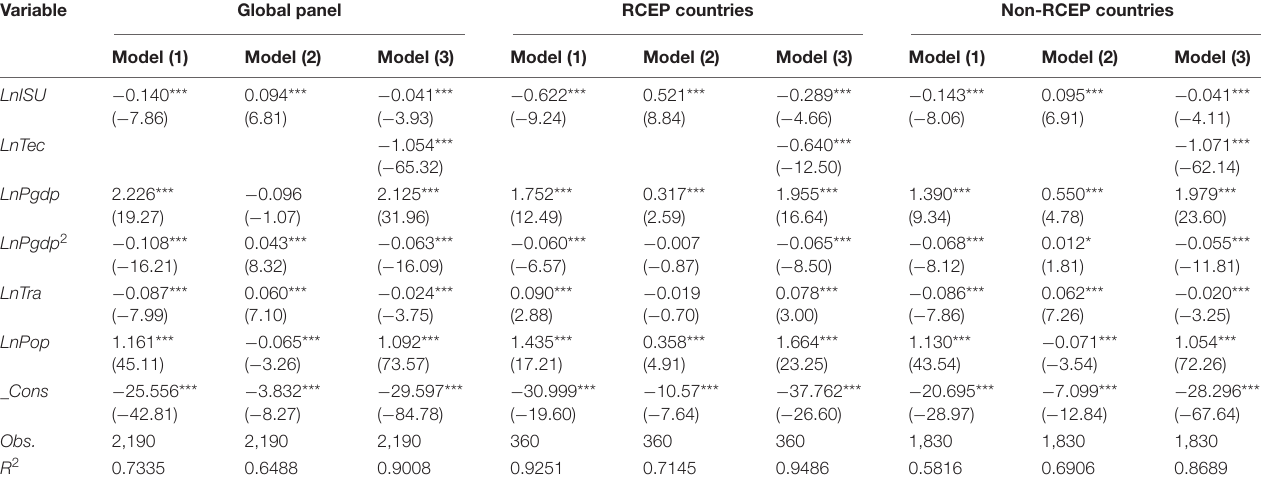
TABLE 8 | Results of the mediating effect between industrial structure upgrading and CO 2